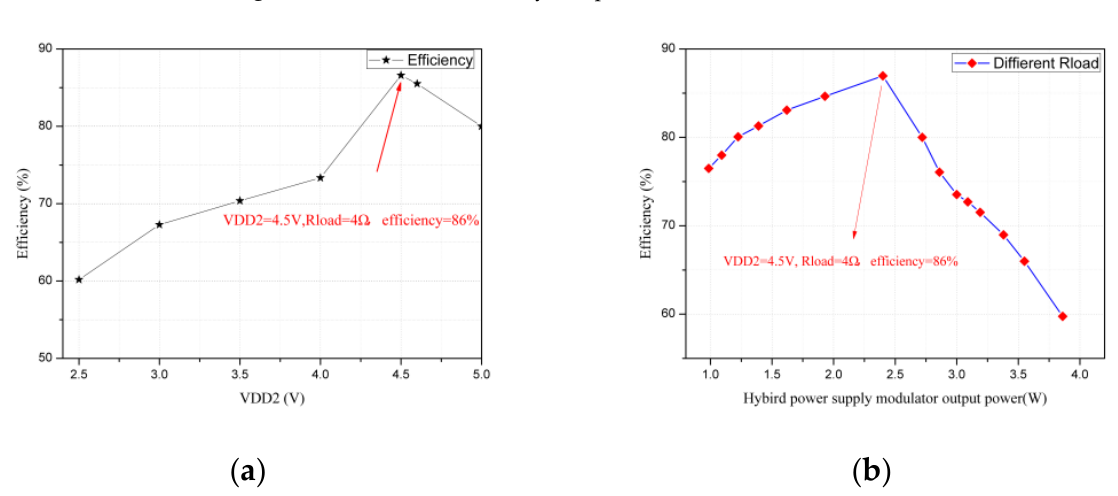
Figure 14. The current of the hybrid power modulator.